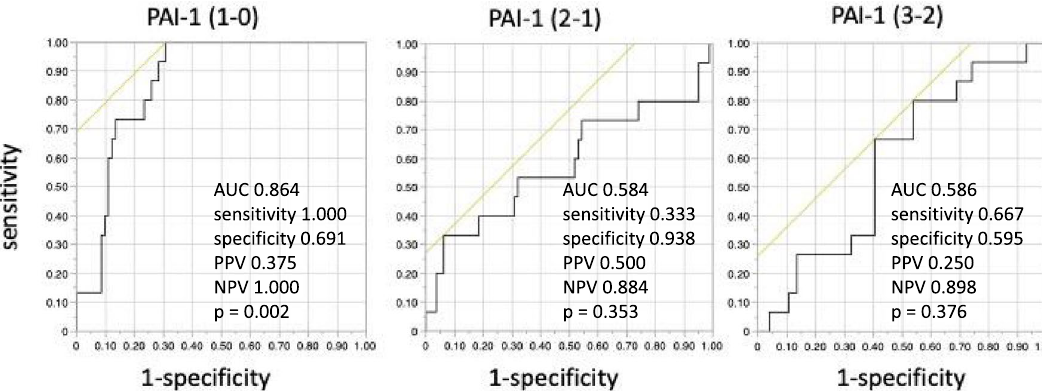
Figure 3. Receiver operating characteristic curve for predicting delirium by plasminogen activator inhibitor-1. Differences in the log-transformed levels of each biomarker between the indicated postoperative days were calculated using subtraction. 1 − 0, subtraction of preoperative PAI-1 values from those on postoperative day 1; 2 − 1, subtraction of values on postoperative day 1 from those on postoperative day 2; 3 − 2, subtraction of values on postoperative day 2 from those on postoperative day 3. Sample size at each point is indicated in online Supporting Information Table S2. Preoperative (POD 0) values of PAI-1 are identical to the dataset published in Ref. 12 . PAI-1, plasminogen activator inhibitor-1; AUC, area under curve; PPV, positive predictive value; NPV, negative predictive